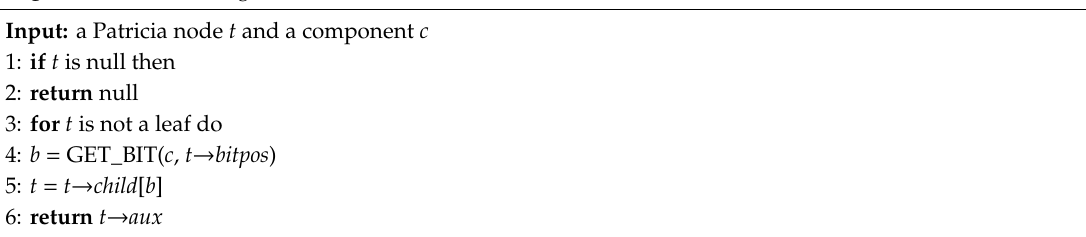
Algorithm 2: Search Algorithm for Patricia